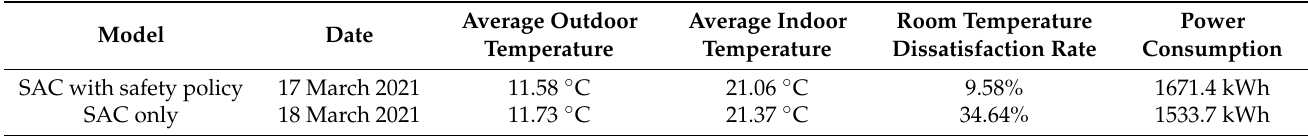
Table 6. Experimental Results of AB test for safety